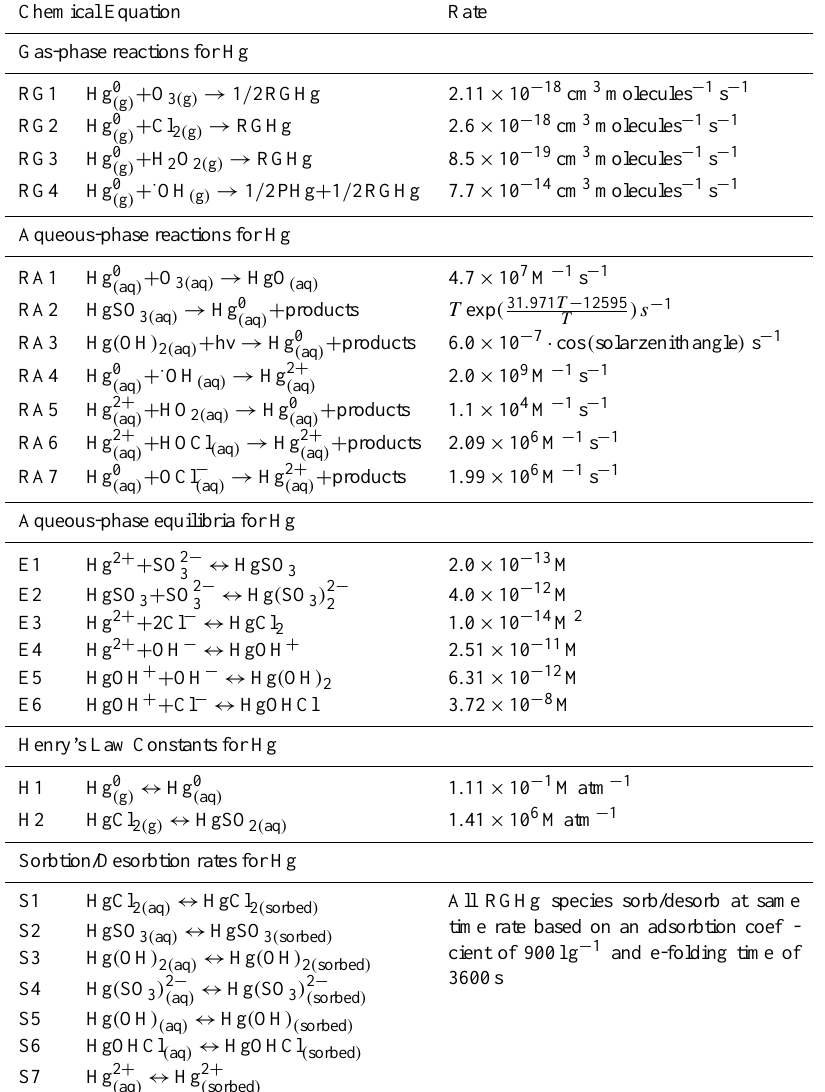
Table A2. Chemical reactions and rates used in the CMAQ-Hg mechanism presented